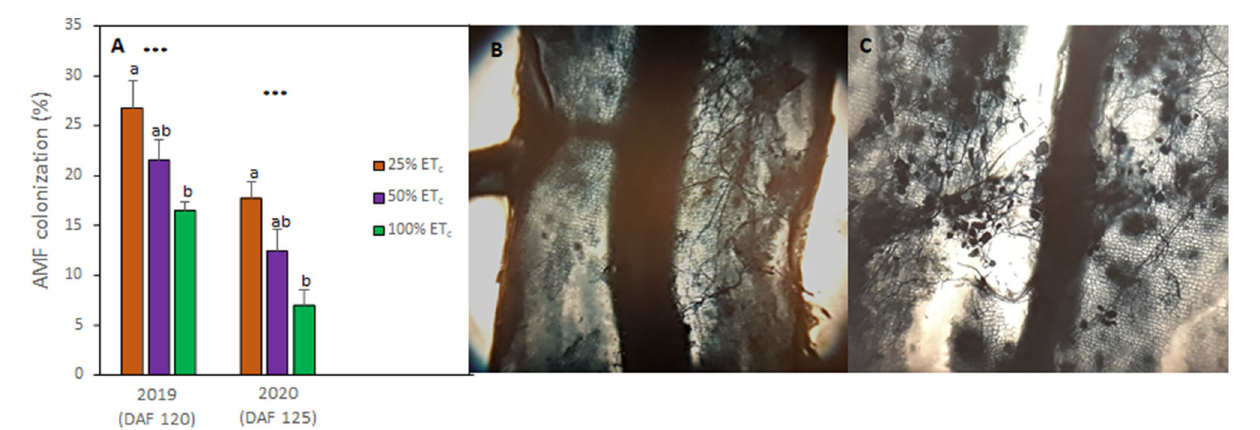
FIGURE 4 | Arbuscular mycorrhizal fungi (AMF) colonization rates of Cabernet Sauvignon grapevines (clone FPS08) subjected to different replacement of crop evapotranspiration (25, 50, and 100% ET c ), collected in Oakville, CA, in 2018–2019 and 2019–2020 growing seasons (A) . Bars represent means ± SE ( n = 6). At each growing season, different letters indicate significant differences ( p ≤ 0.05) between irrigation treatments according to one-way ANOVA followed by Tukey HSD test. *** indicate significance at 0.1% probability level. Microscopic image ( × 100) of fungal structures Cabernet Sauvignon roots present in half of the root fragment (B) and in the whole fragment (C)